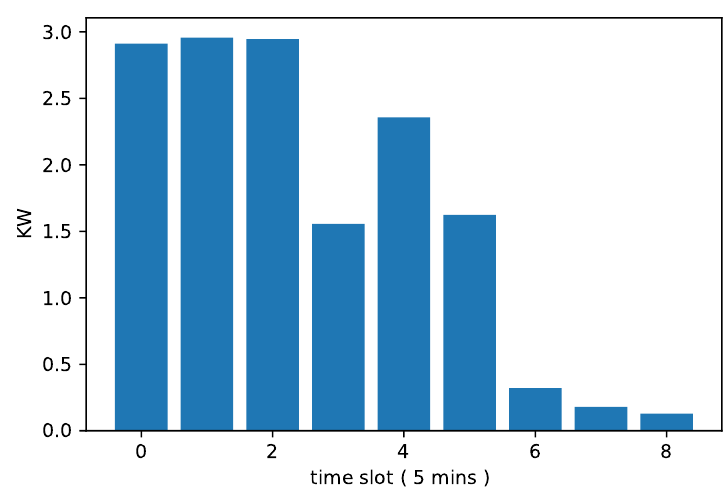
Figure 1. GE-WSM2420D3WW power